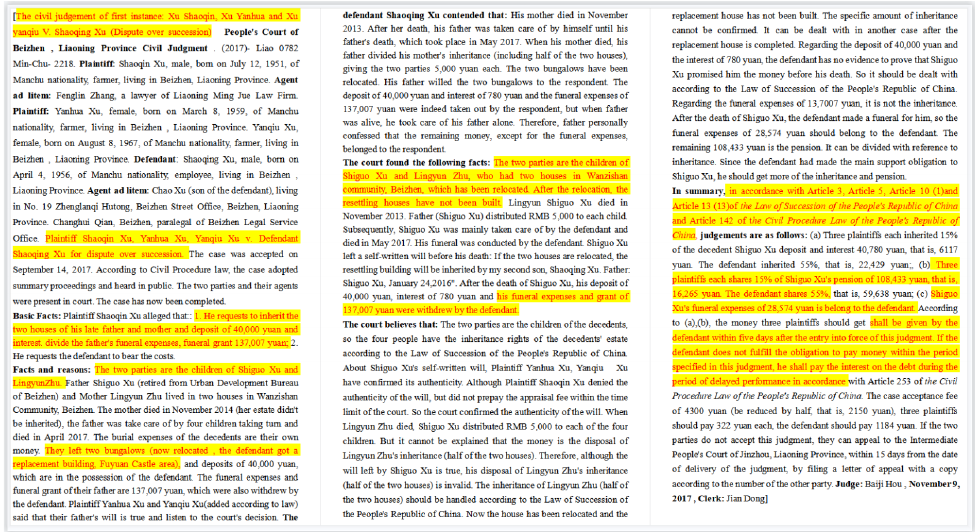
Figure 1. Example of case judgment. This shows how key information is scattered throughout this specific case judgment